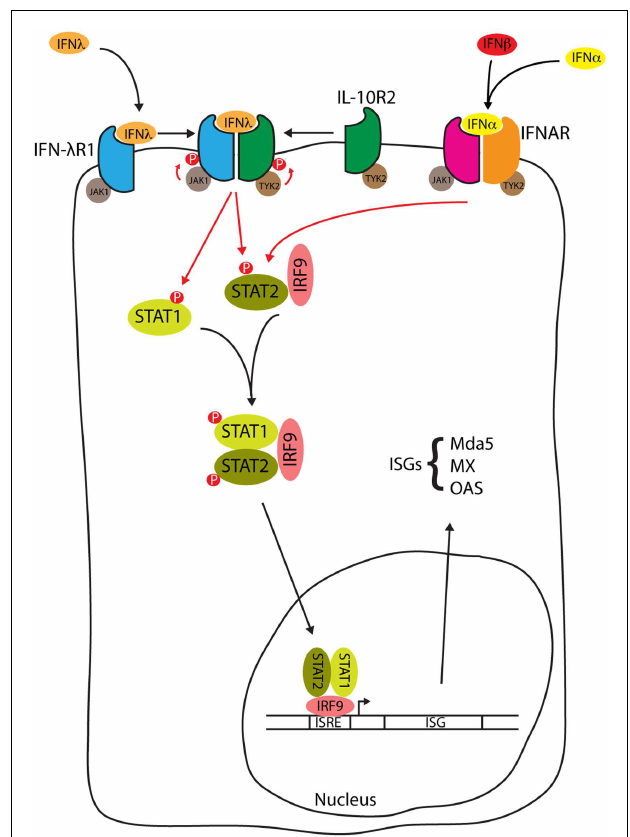
FIGURE 2 | IFN- λ signal transduction .Type III interferon binding to the IFN- λ receptor and type I interferon binding to the IFNAR both activate the JAK1/STAT pathway to form the ISGF3 complex. ISGF3 relocates from the cytosol to the nucleus whereupon binding to ISREs induces the expression of ISGs such as myxovirus (influenza virus) resistance 1 (MX1), melanoma differentiation-associated protein 5 (MDA5), and 2 (cid:48) -5 (cid:48) oligoadenylate synthetase (OAS), see text for